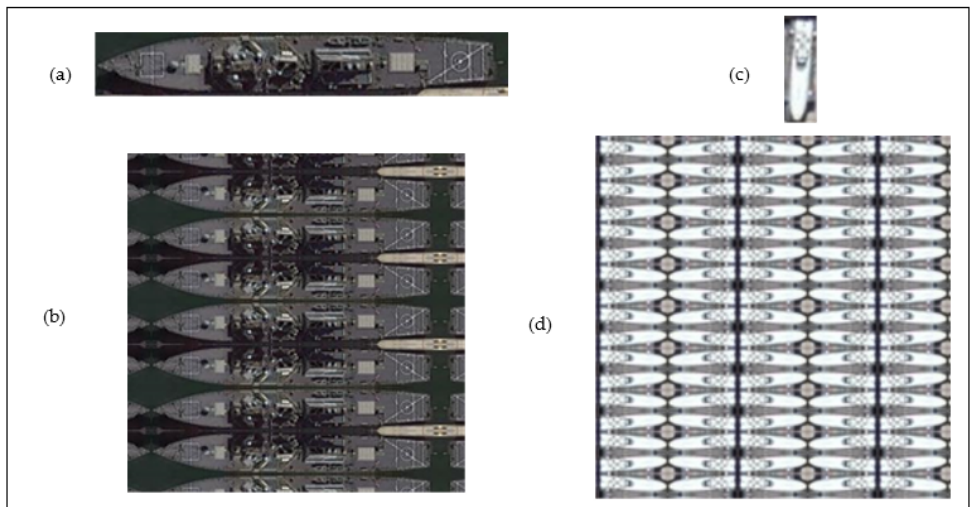
Figure 3. ( a ) Navy ship, ( b ) PFMO applied navy ship; ( c ) Yacht, ( d ) PFMO applied yacht.